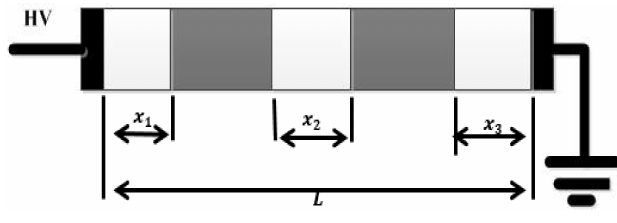
Figure 12. Three dry bands.